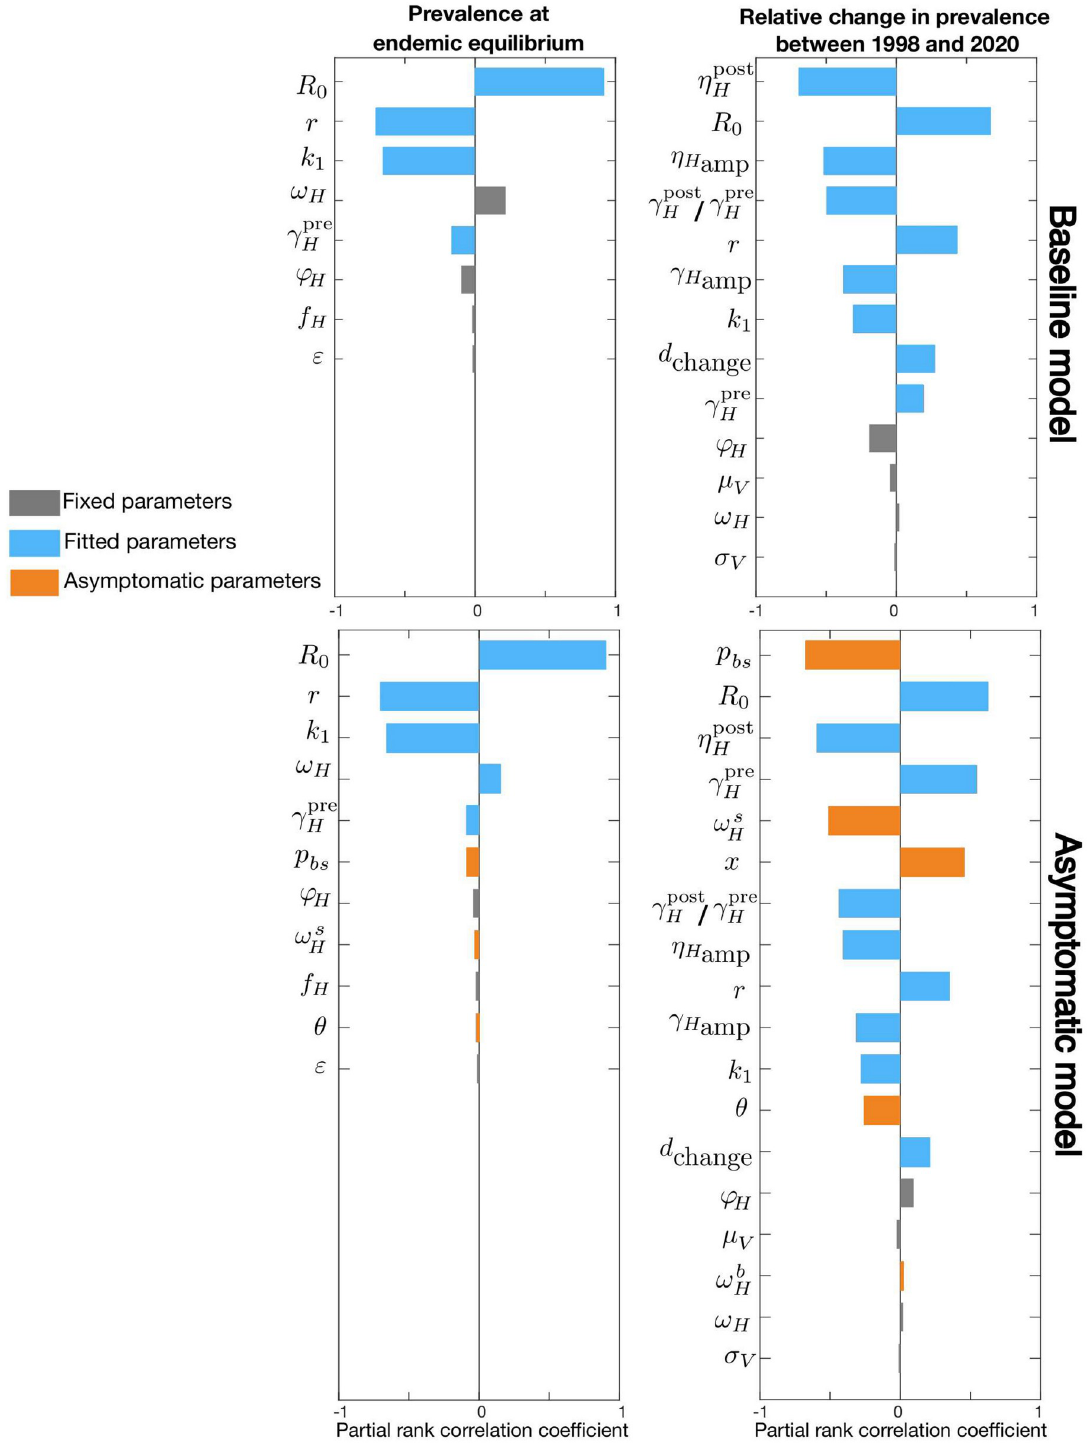
Fig 2. Sensitivity analysis in terms of model parameters. Sensitivity of total human prevalence, I H / N H , analysed for the whole parameter space of the baseline model (first row) and the asymptomatic model (second row). The first column corresponds to the endemic equilibrium configuration, I 0 = N , and second column represents the relative change in prevalence between 1998 and 2020, H H ð 2020 Þ = I 0 . We do not show parameters with sensitivity values below 1% and sort the parameters by their absolute sensitivity value in I H H each plot. Fixed, fitted, and asymptomatic parameters are shown in gray, blue, and orange respectively.